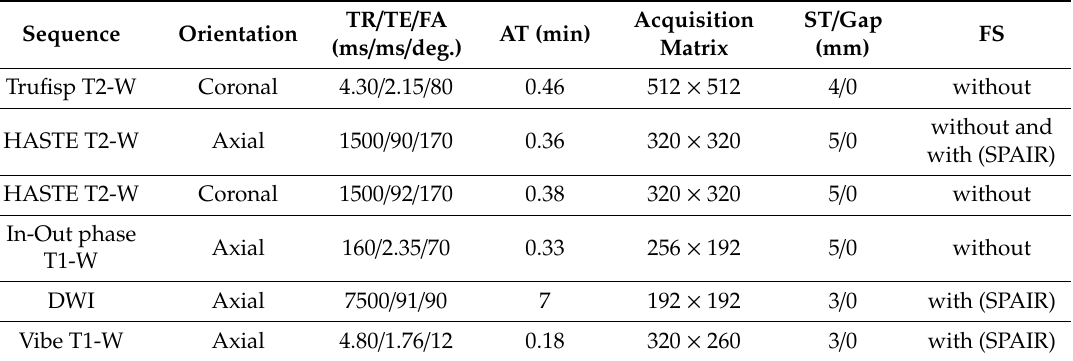
Table 2. Pulse sequence parameters on MR